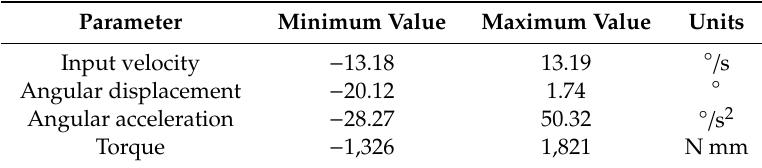
Table 5. Dynamic analysis results for motor 2.